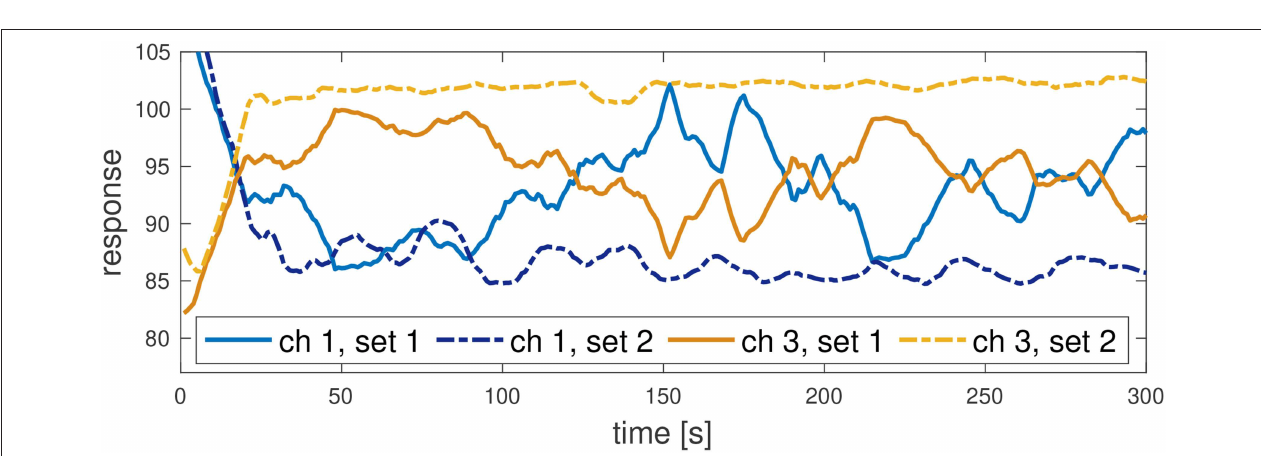
FIGURE 3 | Temporal responses on IMS channels 1 and 3 for lemon peel. Scent source was presented to ChemPro100i from a plate. Set 1 was collected on 25 October 2017 and set 2 on 21 November 2017.